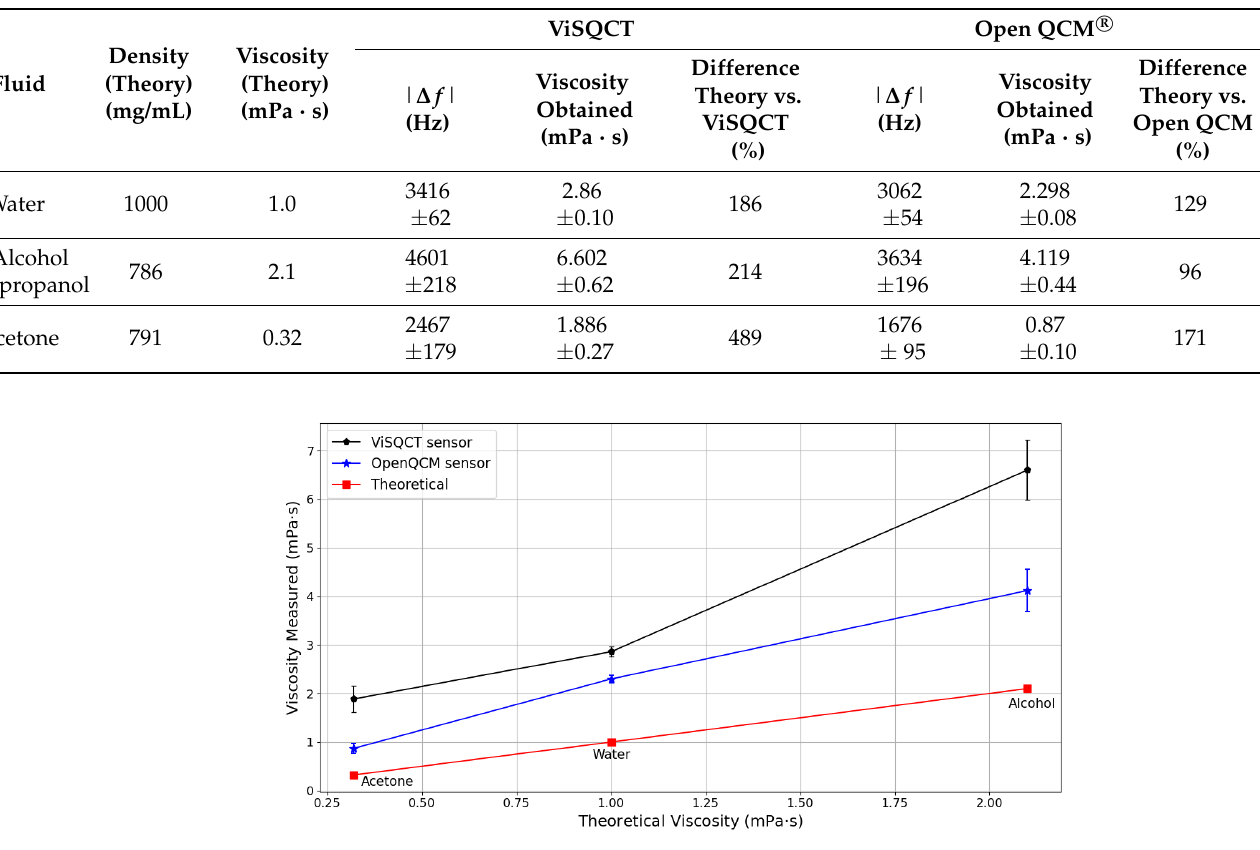
Figure 4. Comparison of measured and theoretical viscosities of: Water, Acetone, and